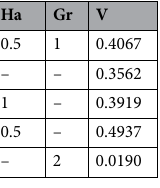
Table 1. Finite difference results for velocity.